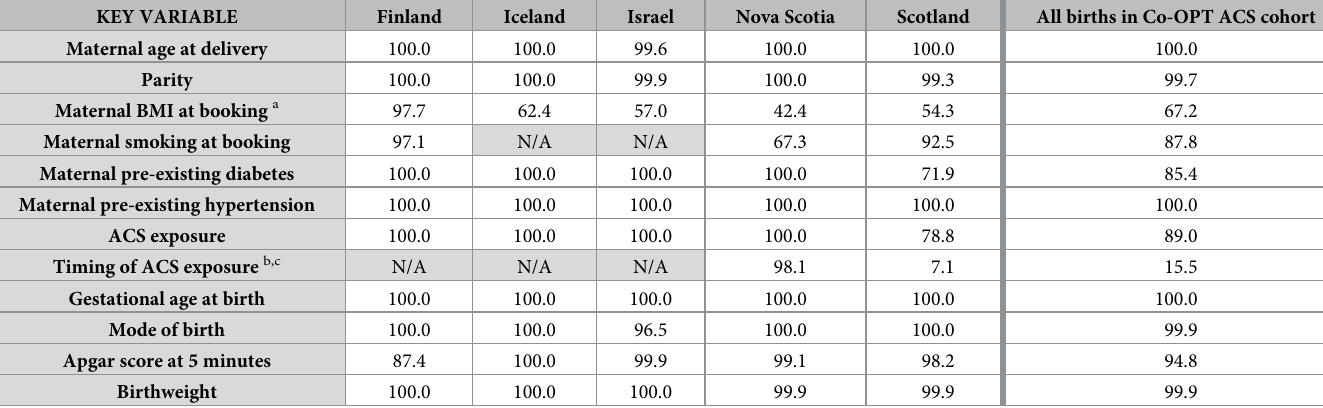
Table 3. Data completeness for key maternal and neonatal variables within Co-OPT ACS cohort, per region, and in the whole cohort